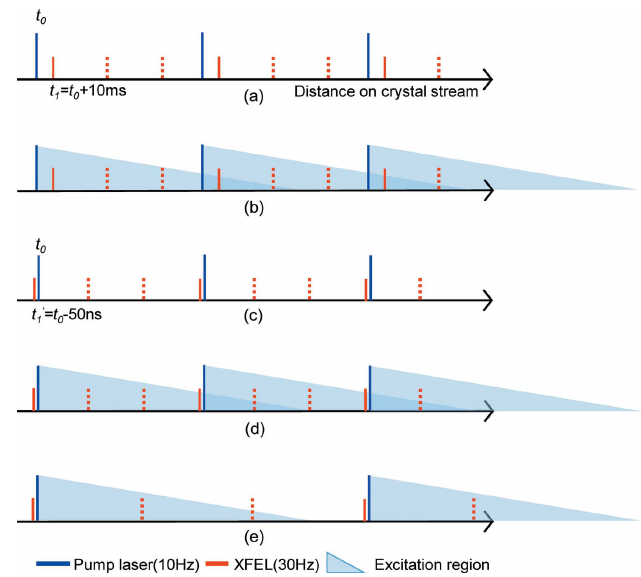
Figure 2 Relative timing of the pump lasers and XFEL pulses with (cid:2) t = 10 ms ( a ) and (cid:2) t = (cid:3) 50 ns ( c ). Schematic representations of the boundaries where the pump lasers reaching a slower flow rate with (cid:2) t = 10 ms ( b ) or (cid:2) t = (cid:3) 50 ns ( d ), and at a faster flow rate with (cid:2) t = (cid:3) 50 ns ( e ). Note that the region exposed to XFEL pulses interacts with multiple pump lasers ( b ) or an unintended laser ( d ) when a slower flow rate was employed. XFEL pulses that were not recorded for the ‘light’ datasets are shown as dashed lines. The excitation region is shown as a triangle for clarity, but it is not a linear profile in the